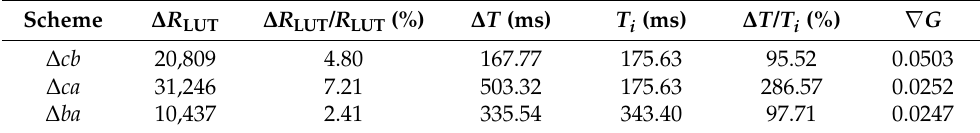
Table 3. ∇ G of schemes in interferogram generation with different threads.